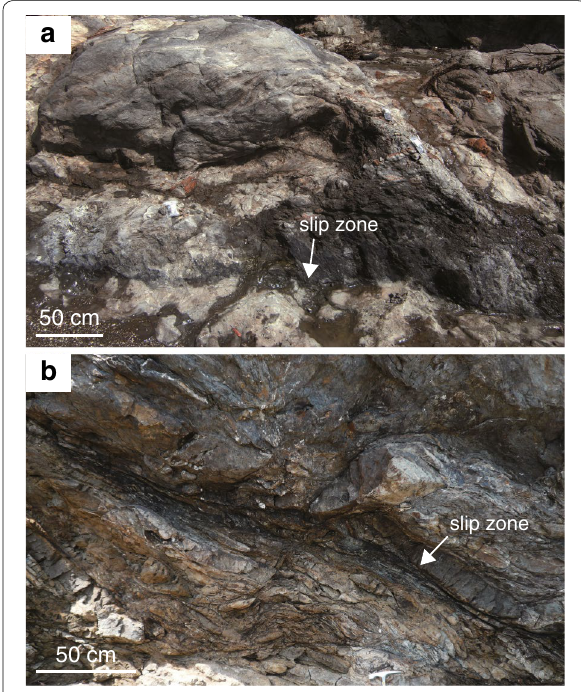
Fig. 2 Outcrop photographs of the deformed zones. a A major thrust in the Emi Group. b A representative OST within the Kure Mélange. Locations of photographs shown in Fig. 1b,